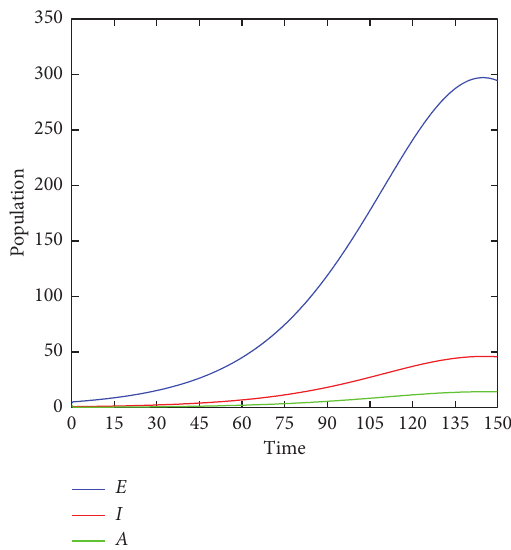
Figure 4: Simulation for the number of Exposed, Symptomatic Infected, and Asymptomatic Infected with 90% of population obeying the rule of social distancing.